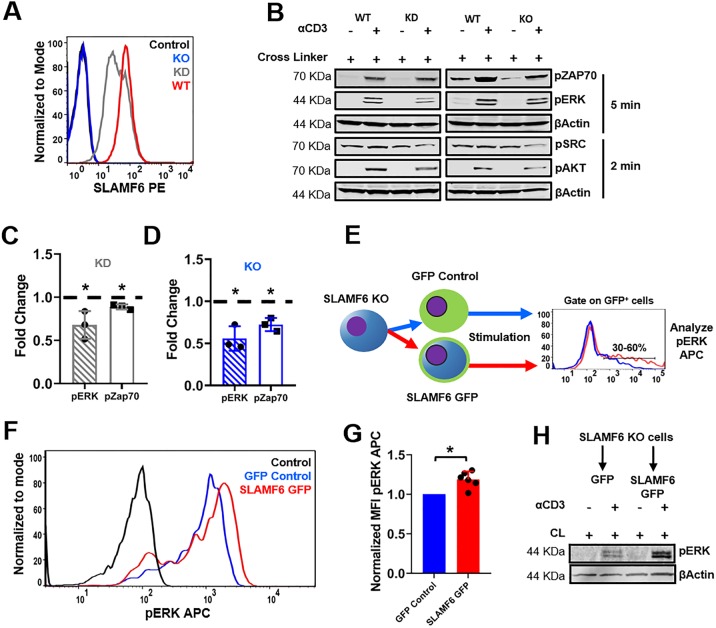
SLAMF6 knock down or knock out leads to a decrease in TCR activation.(A) Flow cytometry verification of SLAMF6 KO via CRISPR-Cas9 and SLAMF6 KD via shRNA. (B) WT Jurkat T cells, SLAMF6 KD and SLAMF6 KO were treated with αCD3 + cross linker and then stimulated at 37° C for 5 min. Blots were generated by lysing the cells, separating the lysates by tris-glycine PAGE and transferring to a nitrocellulose membrane. pZAP70, pERK, pSRC and pAKT were assessed. Quantification was given for three independent experiments (n = 3) for SLAMF6 KD Jurkat T cells (C) and SLAMF6 KO Jurkat T cells (D). *p<0.05 for an unpaired student t-test. Further quantification of pSRC and pAKT can be found in S5 Fig. (E) A schematic of the flow cytometry assay used to rescue SLAMF6 function. SLAMF6 KO Jurkat T cells were transiently transfected with GFP control or SLAMF6 GFP. Cells were treated with αCD3 + cross linker, stimulated at 37° C for 5 min and subjected to Flow cytometry. Cell were gated on GFP positive cells and analyzed for pERK APC. (F) Representative curve for functional recue of SLAMF6 by flow cytometry. (G) Quantification for six independent functional recue of SLAMF6 by flow cytometry experiments (n = 6). *p<0.05 for an unpaired student t-test. (H) Functional recue of SLAMF6 by western blot. SLAMF6 KO cells were transiently transfected with GFP control (pEGFPN1 vector) or SLAMF6 GFP (SLAMF6 pEGFPN1 vector) then treated with αCD3 + cross linker and stimulated at 37° C for 5 min. Blot was generated and pERK were assessed.